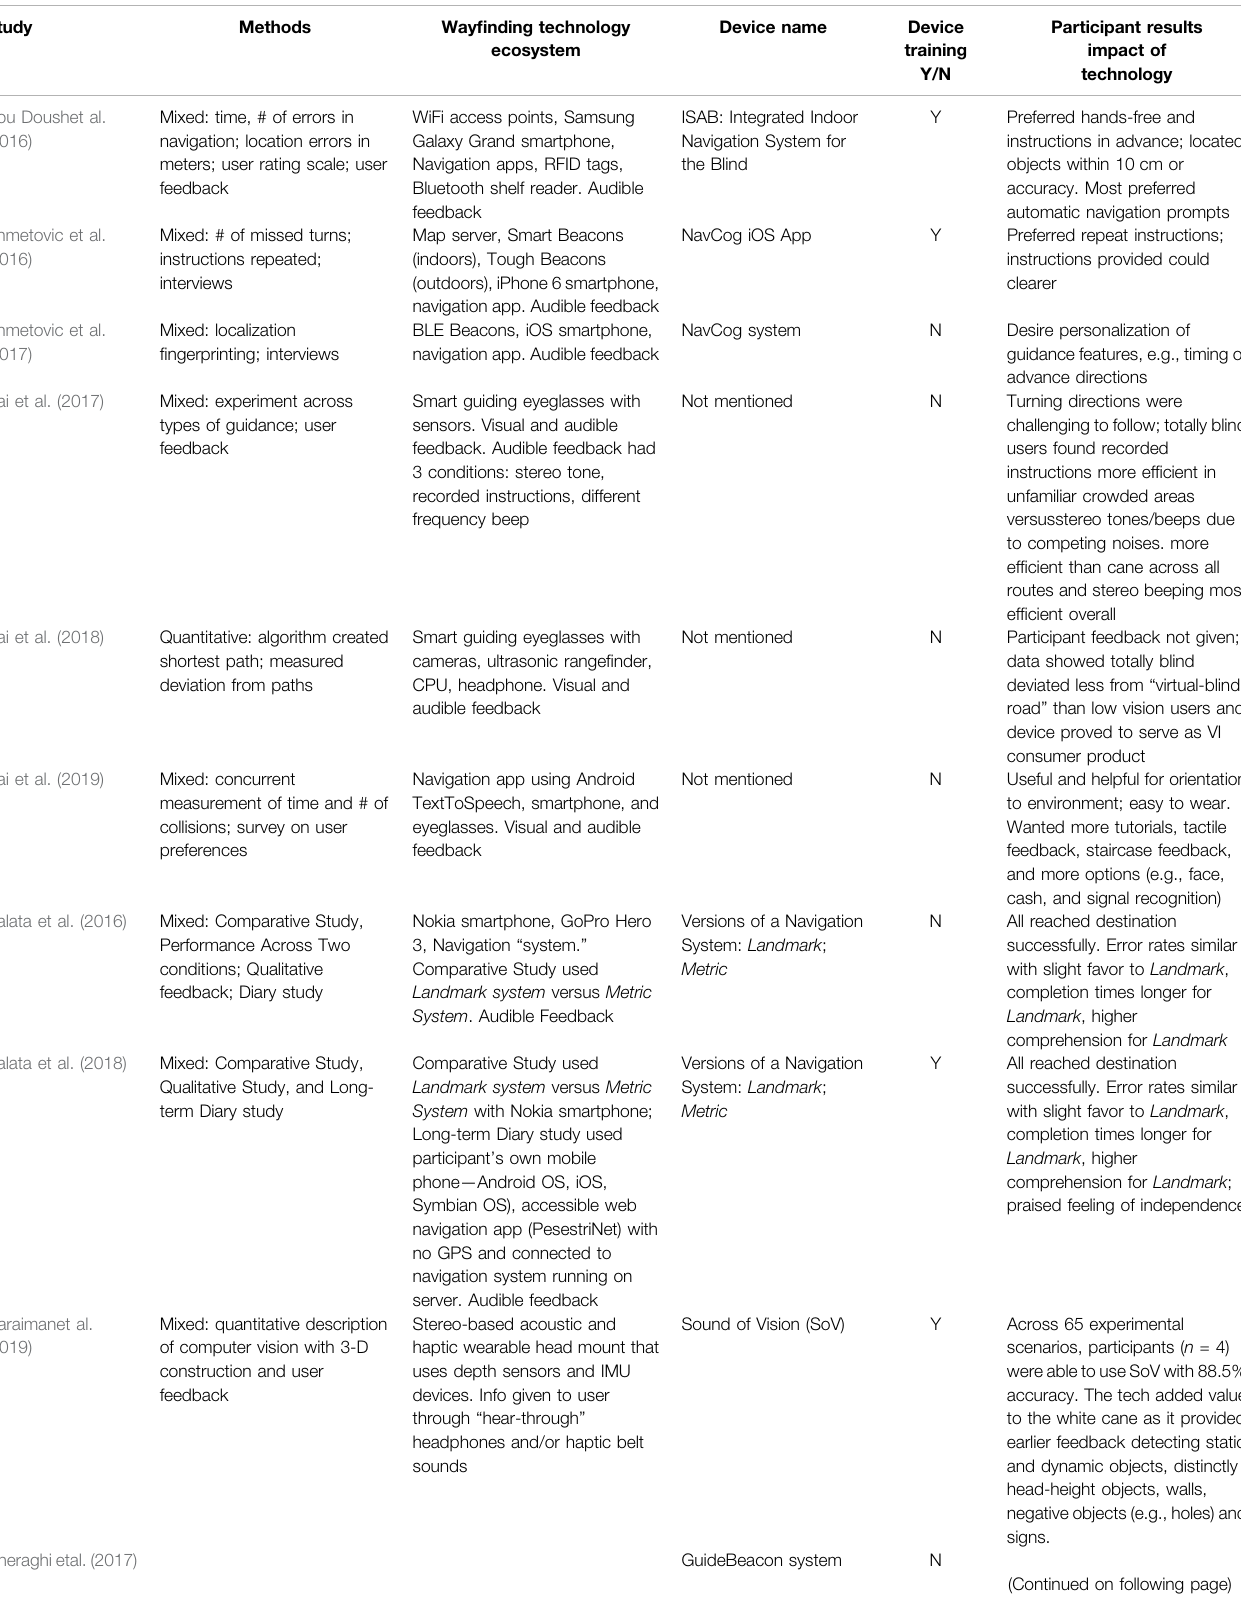
TABLE 1 | Technologies and